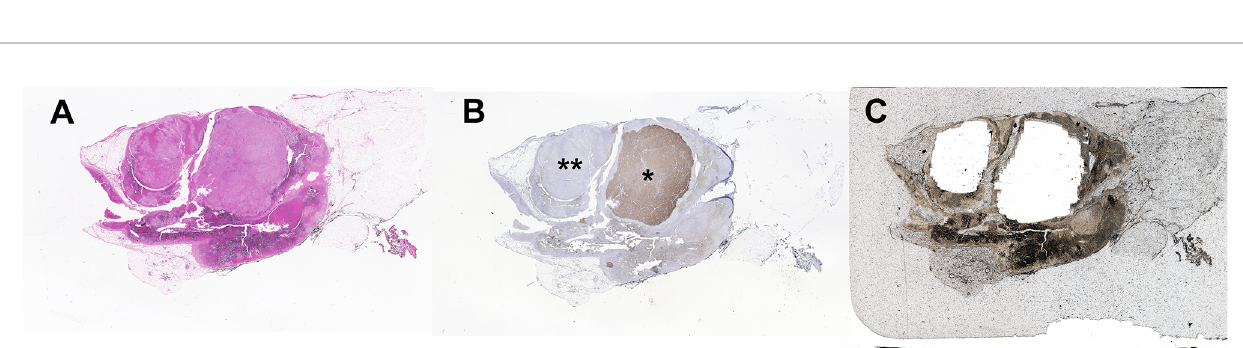
FIGURE 2 | Example of a multinodular adrenal sample from a patient with primary aldosteronism that illustrates the bene fi t of CYP11B2 IHC-guided DNA capture. (A) Hematoxylin and eosin staining, (B) CYP11B2 immunohistochemistry; *, aldosterone-producing adenoma (APA); **, CYP11B2-negative tumor, (C) Post-captured unstained FFPE adrenal tissue section. For DNA isolation, an APA and a CYP11B2-negative tumor were selectively scraped based on the results of CYP11B2